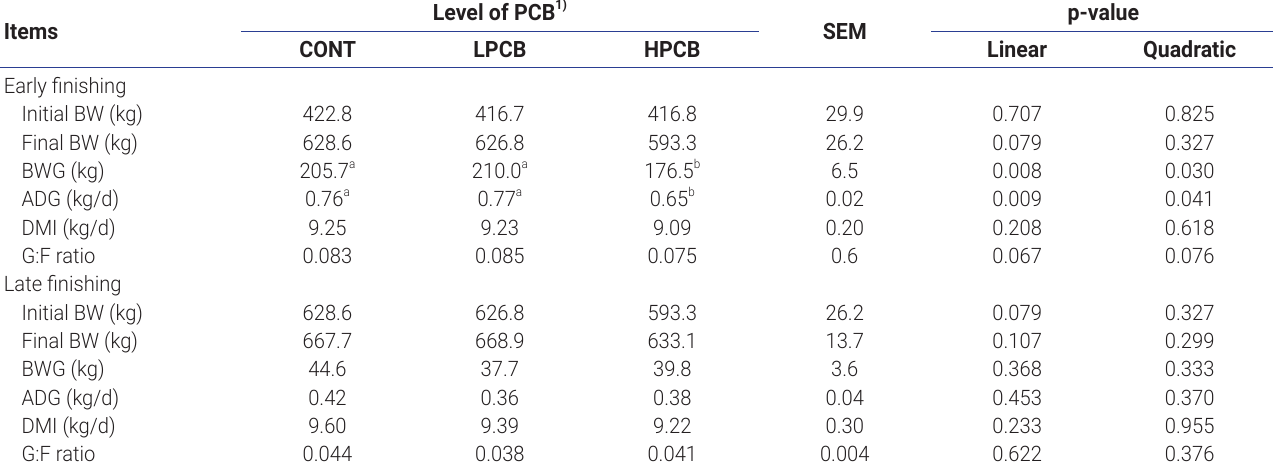
Table 3. Effects of pineapple cannery by-product on dry matter intake, body weight, average daily gain, and gain to feed ratio of finishing Hanwoo